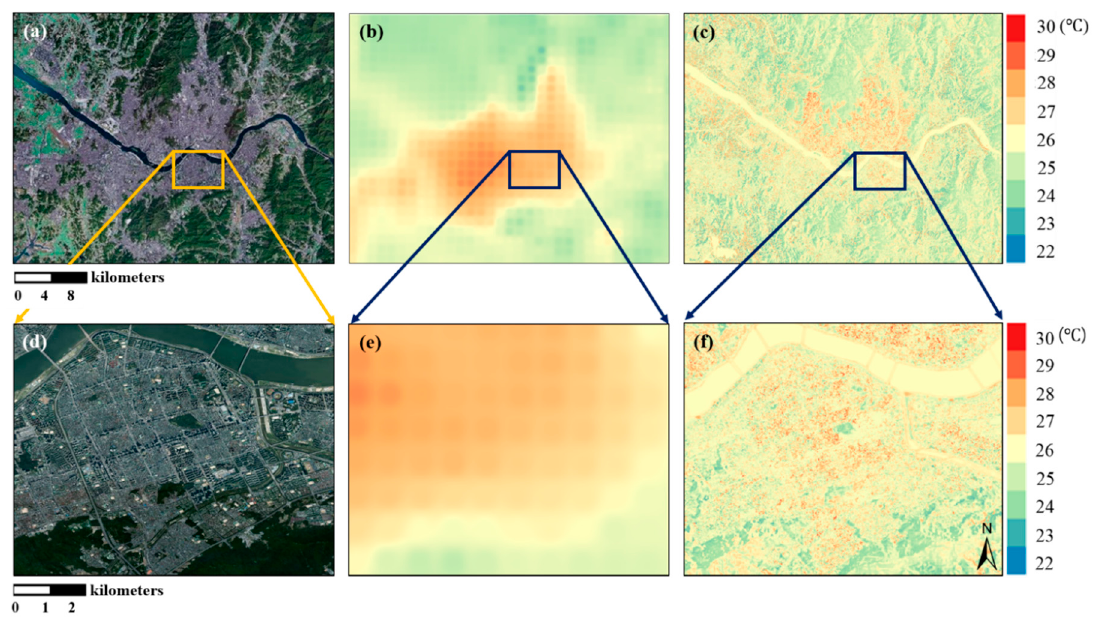
Figure 11. Spatial accuracy evaluation for a tropical night (forecast day: August 4, 2017, 21:00 UTC). ( a ) Map of Seoul; ( b ) local data Assimilation and prediction system (LDAPS) temperatures across Seoul; ( c ) urban meteorological information system (UMIS) temperatures across Seoul; ( d ) map of the Gangnam district; ( e ) LDAPS temperatures across the Gangnam district; ( f ) UMIS temperatures across the Gangnam district.